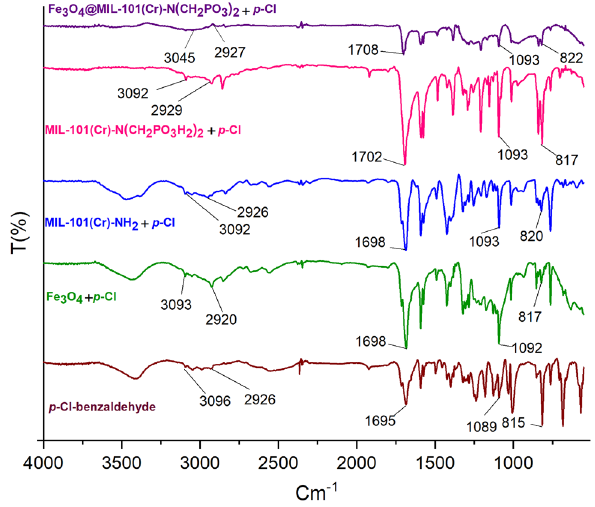
Figure 11. FT-IR spectra of p -Cl-benzaldehyde in percent of Fe 3 O 4 , MIL-101(Cr)-NH 2 , MIL-101(Cr)- N(CH